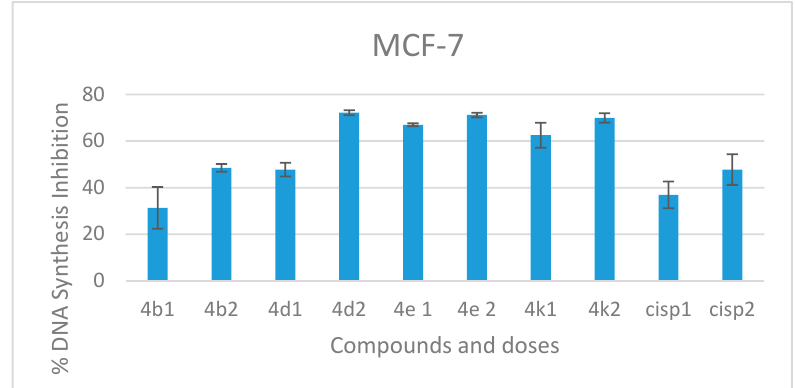
Figure 3. DNA synthesis inhibitory activity of compounds 4b , 4d , 4e , 4k and cisplatin on MCF-7 cells. Mean percent absorbance of untreated control cells were assumed 0%. In addition, two different concentrations (1: IC 50 /2; 2: IC 50 µM) of test compounds and cisplatin were given. Data points represent means for three independent wells ± SD. p < 0.05.